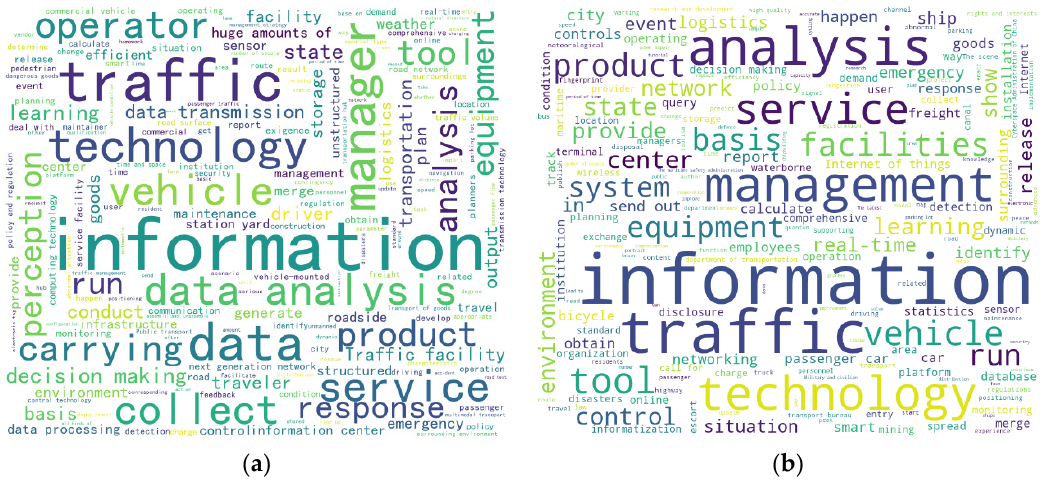
Figure 5. Word cloud of function text ( a ) and topic keywords word ( b ) .